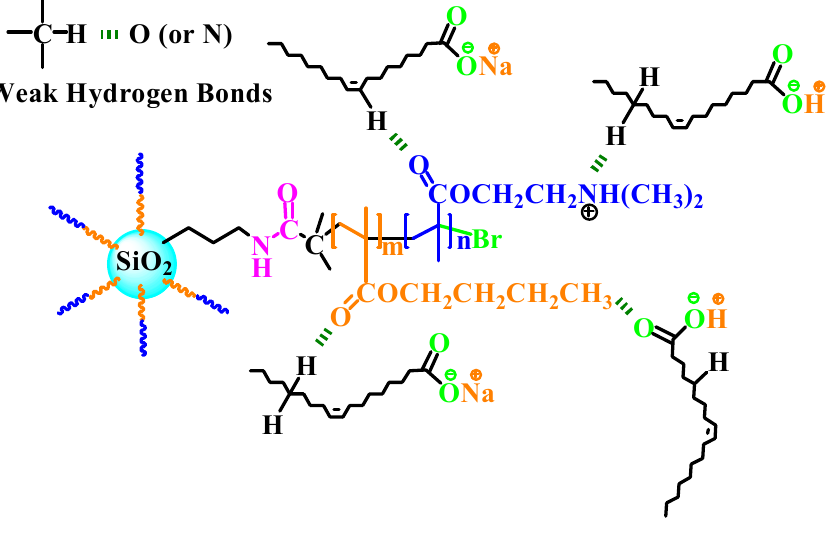
Figure 8. The proposed mechanisms for NaOL adsorption.